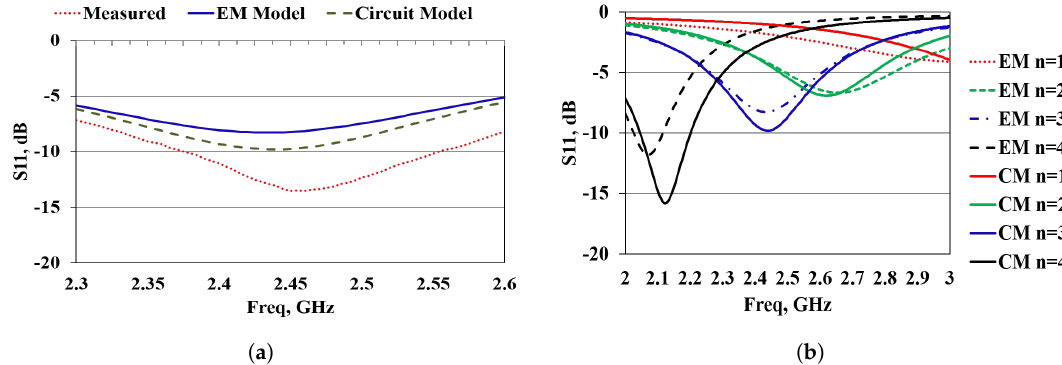
Figure 4. The simulation characteristics of the RF rectifier circuit, ( a ) return loss S 11 ; ( b ) effect of cascading L-slot along the transmission line (EM: stands for EM model simulation, CM: circuit model simulation, and n represents the number of